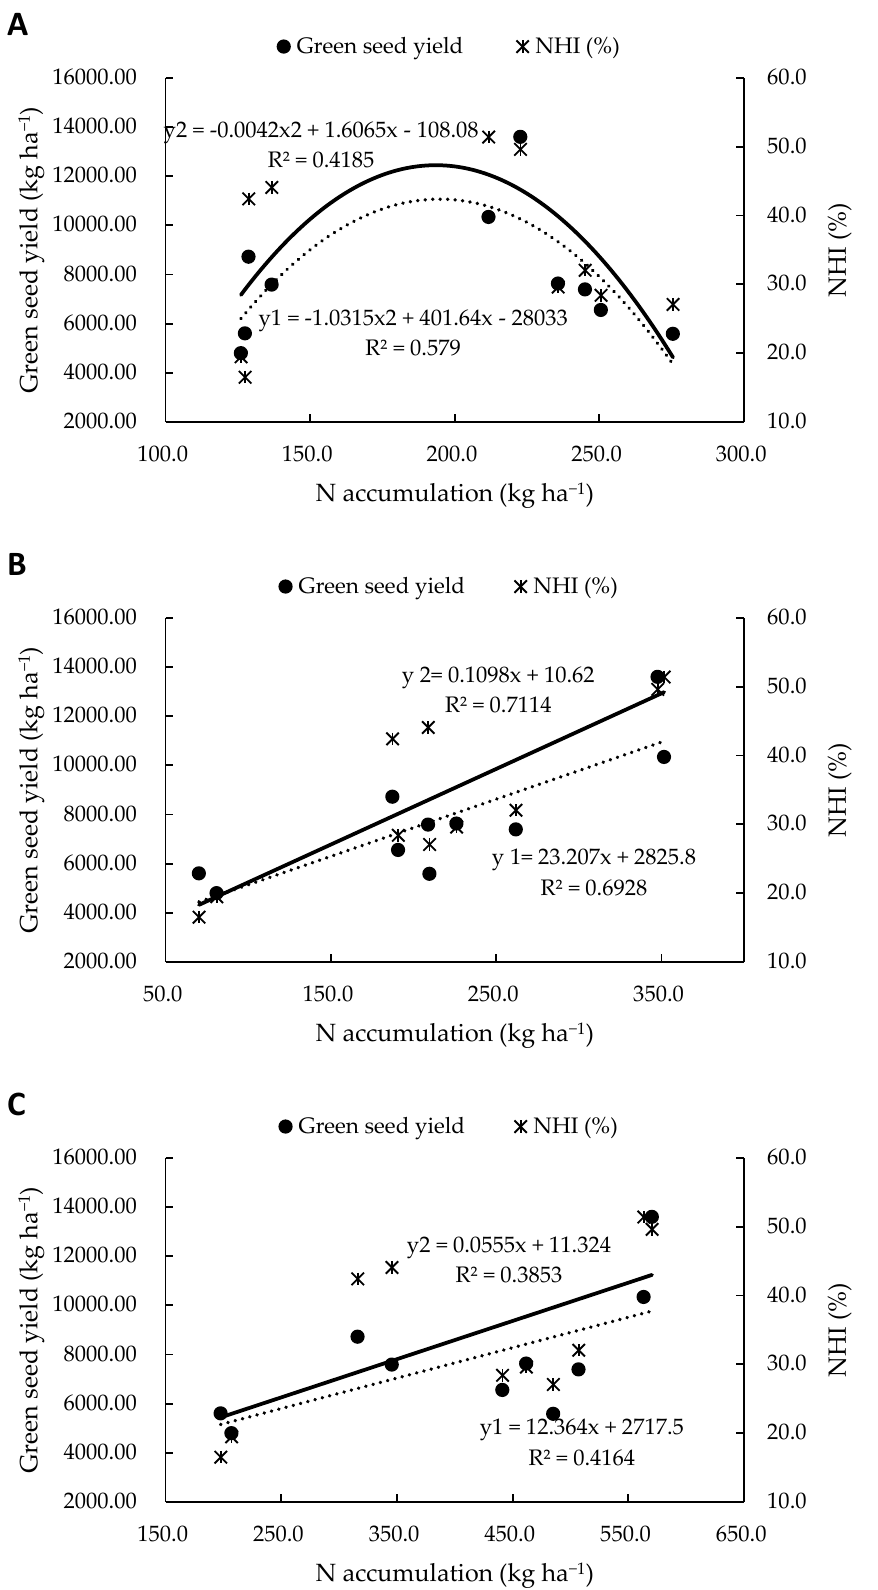
Figure 2. The relationship of nitrogen accumulation in different organs with green seed yield and NHI. Note: ( A – C ), respectively, represent the relationship of nitrogen accumulation in vegetative organs (stem + leaf), reproductive organs (pod shells + green seed) and shoots with the green seed yield (y1) and NHI